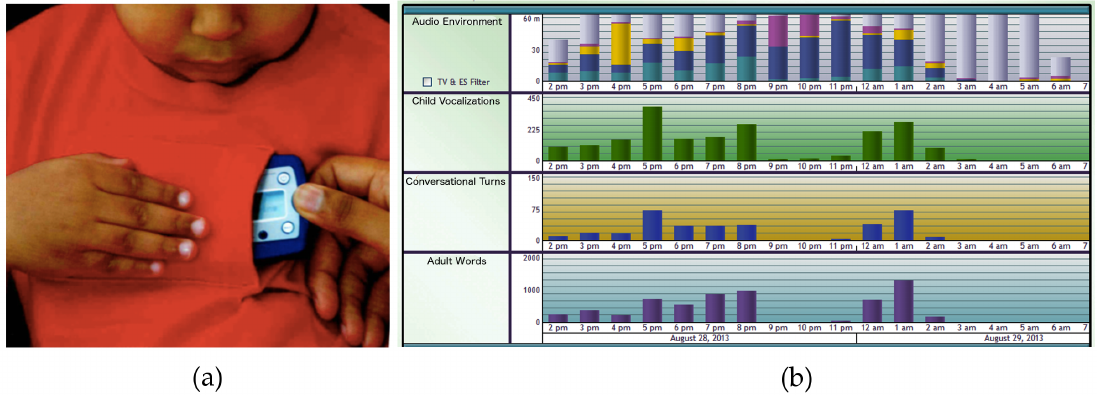
Figure 7. The Language ENvironment Analysis (LENA) device. ( a ) Custom-designed clothing with a pocket to insert the recorder; ( b ) Software interface of LENA showing the audio environment, child’s vocalizations, conversational turns and adult words throughout the day. Images courtesy of Dr. M. Aldosari, Cleveland